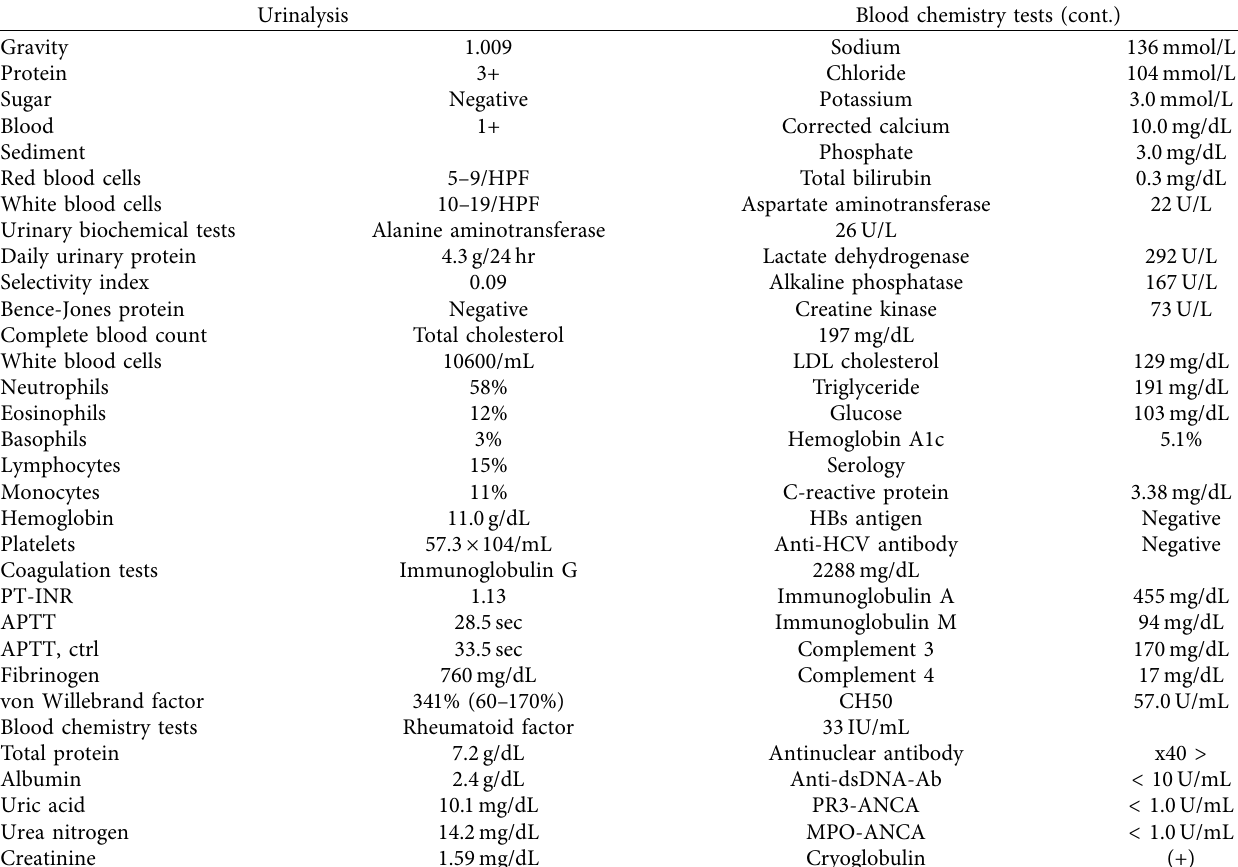
Table 1: Laboratory